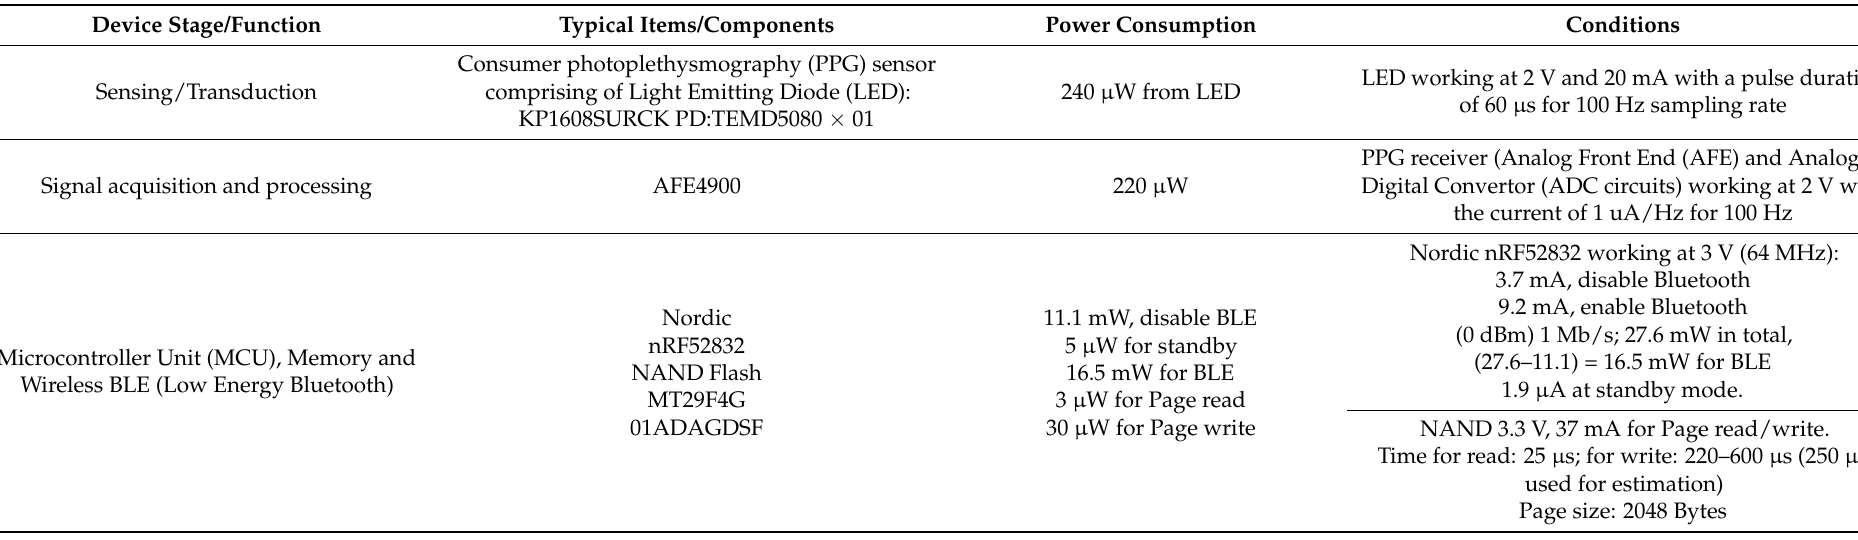
Table 1. The energy consumption of the key components in a wireless sensor system monitoring PPG, ECG, and temperature simultaneously. Table adapted from Yu et al.